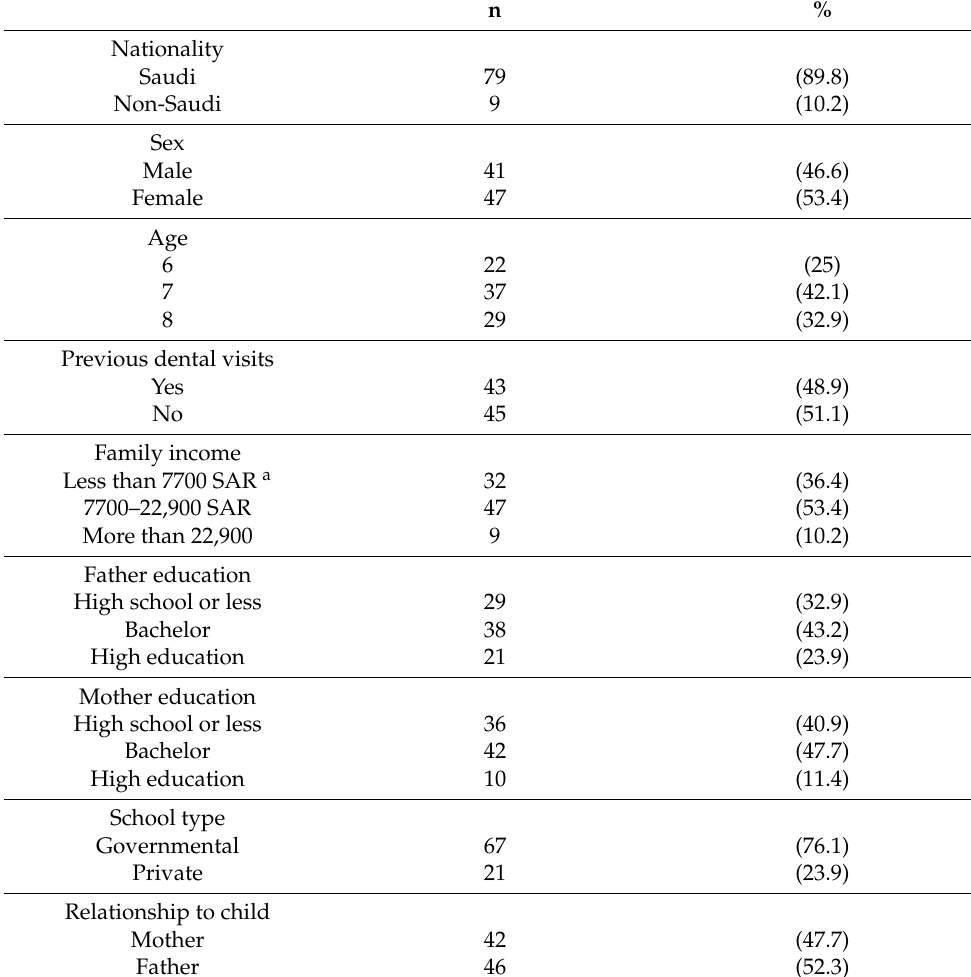
Table 1. Background characteristics by study